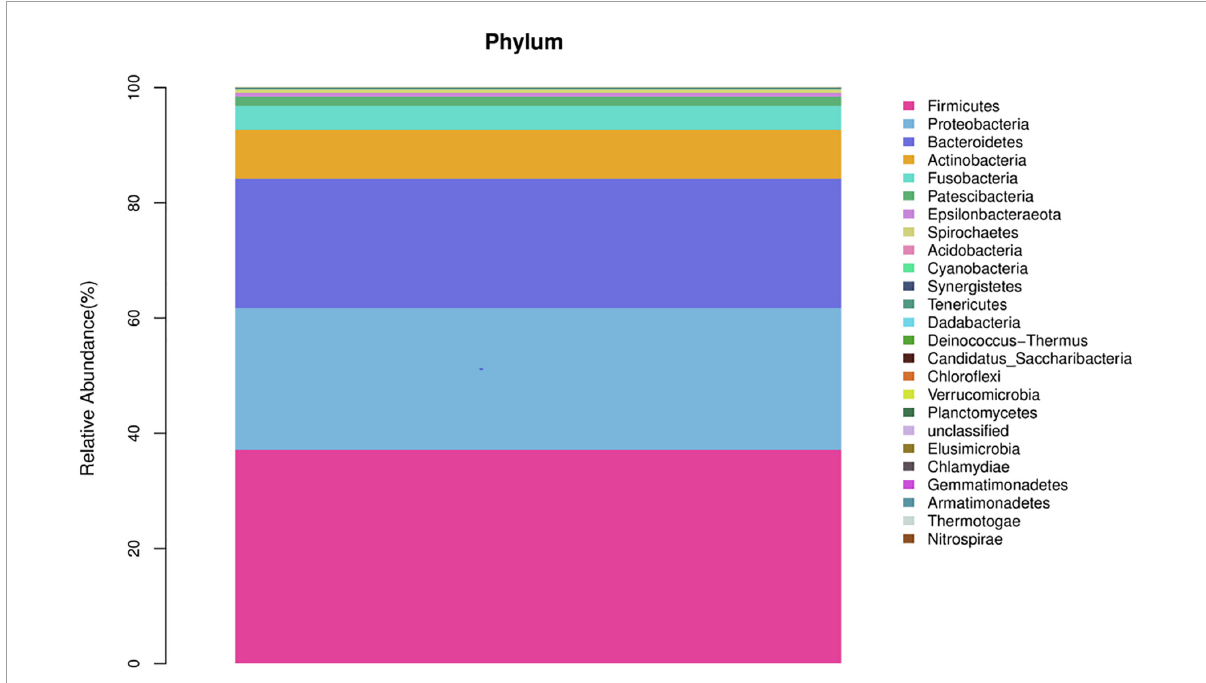
FIGURE1 Histogram of microecological species distribution in healthy airways at the phylum level.